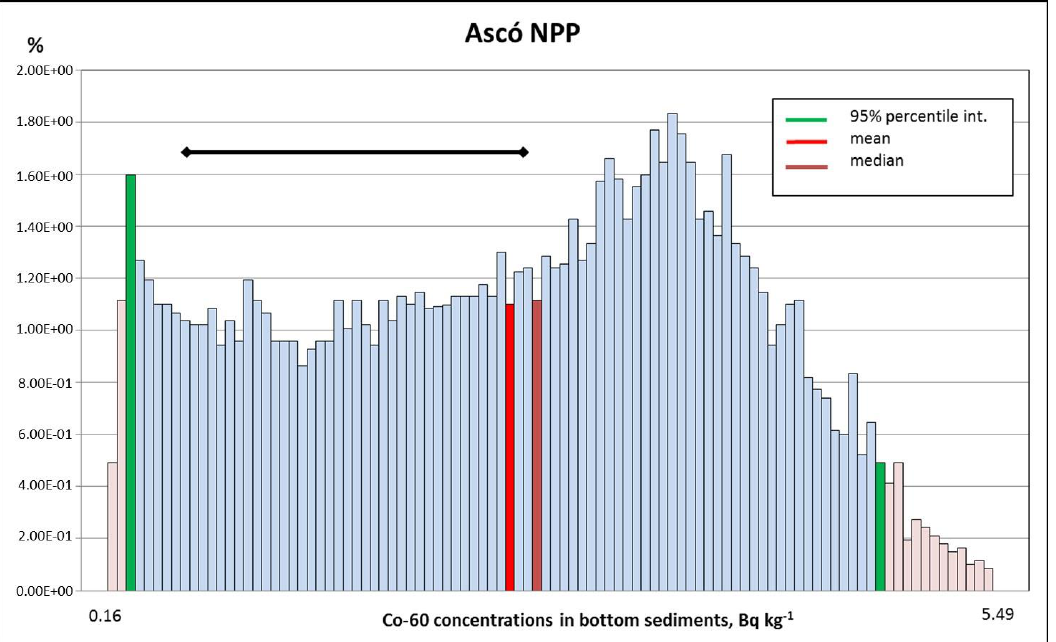
Figure 3. Co-60 concentrations calculated in one point in bottom sediments (Bq kg − 1 ) at the Ebro river (Asc ó ). Black segment represents the range of the published